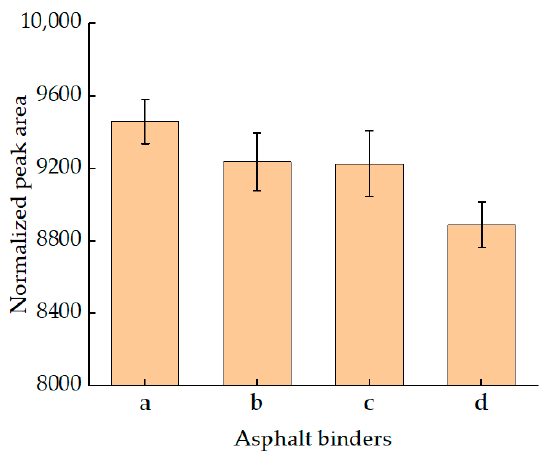
Figure 3. The NPA of unaged SBS asphalt binders.